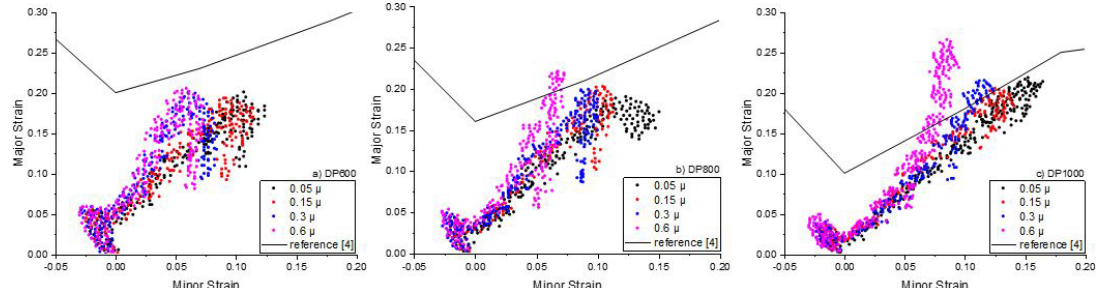
Figure 6. Strain distribution - friction coefficient relations